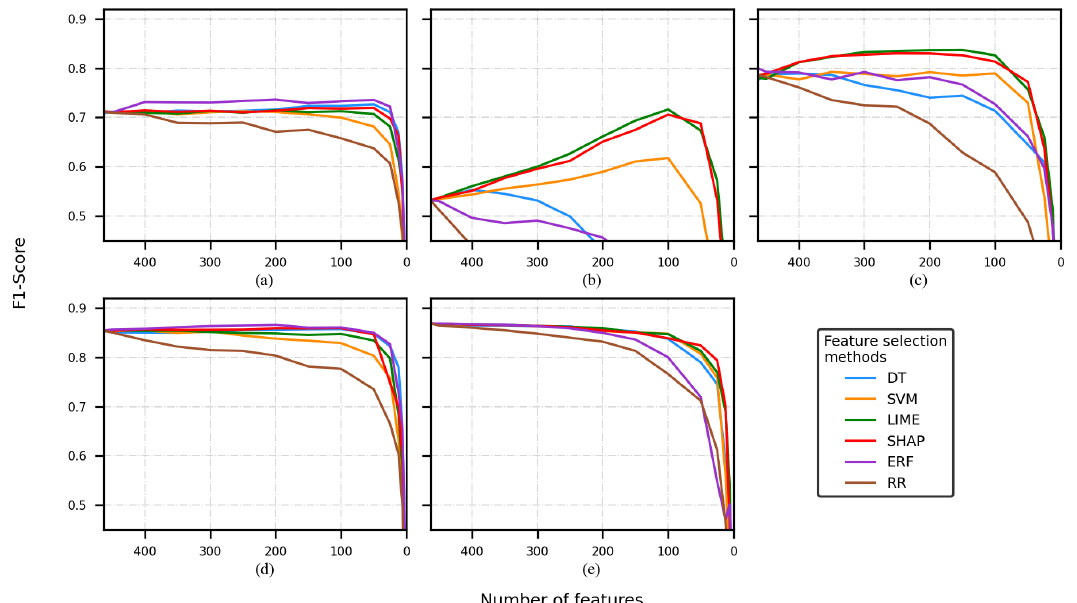
Figure 5. F1-score of the model is obtained by using a different number of features, using the Siena dataset and FS2. Classification model used: ( a ) decision tree, ( b ) support vector machine, ( c ) artificial neural network, ( d ) random forest, and ( e ) K-nearest